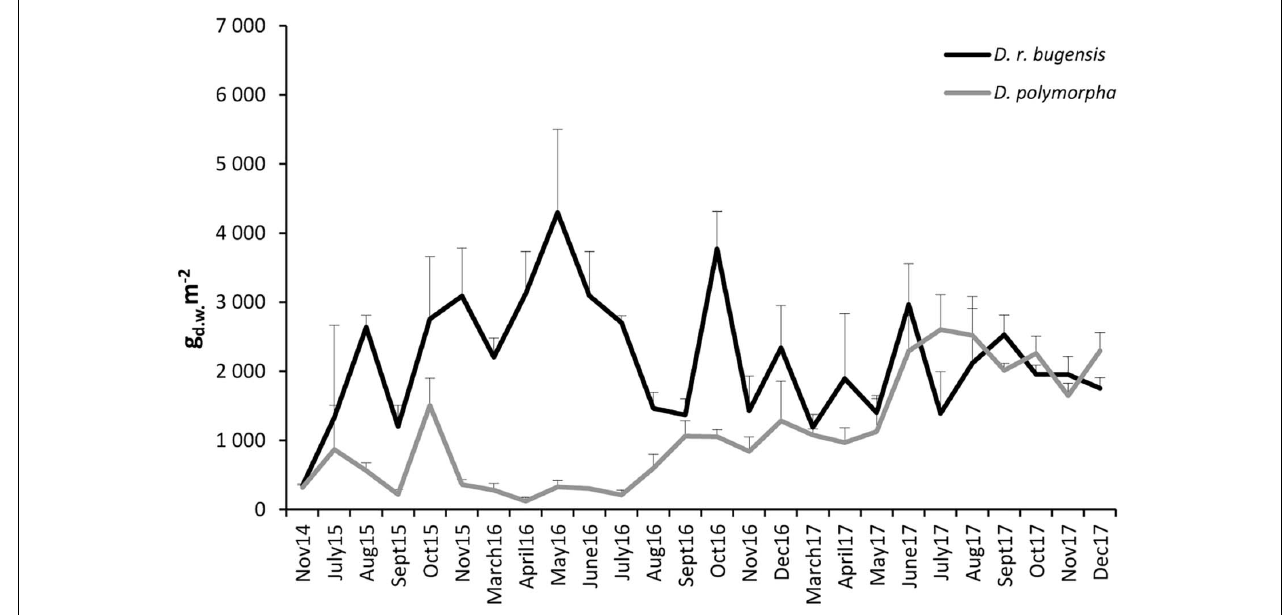
FIGURE 4 | Changes in mean biomasses of D. polymorpha and D. r. bugensis in 2014–2017 at station ZS6; error bars denote standard